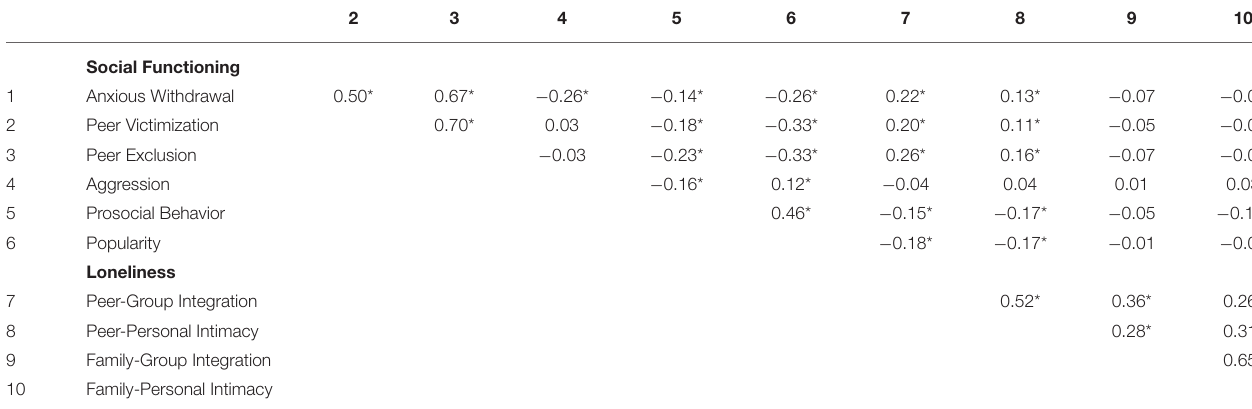
TABLE 1 | Correlations between Study